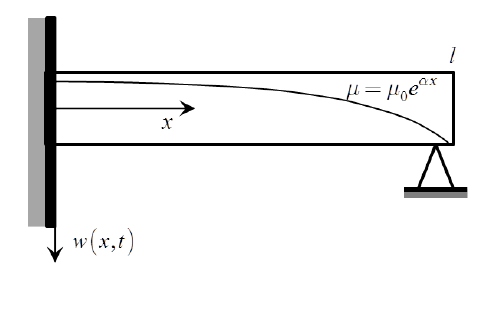
Fig. 1. Clamped-simply supported beam